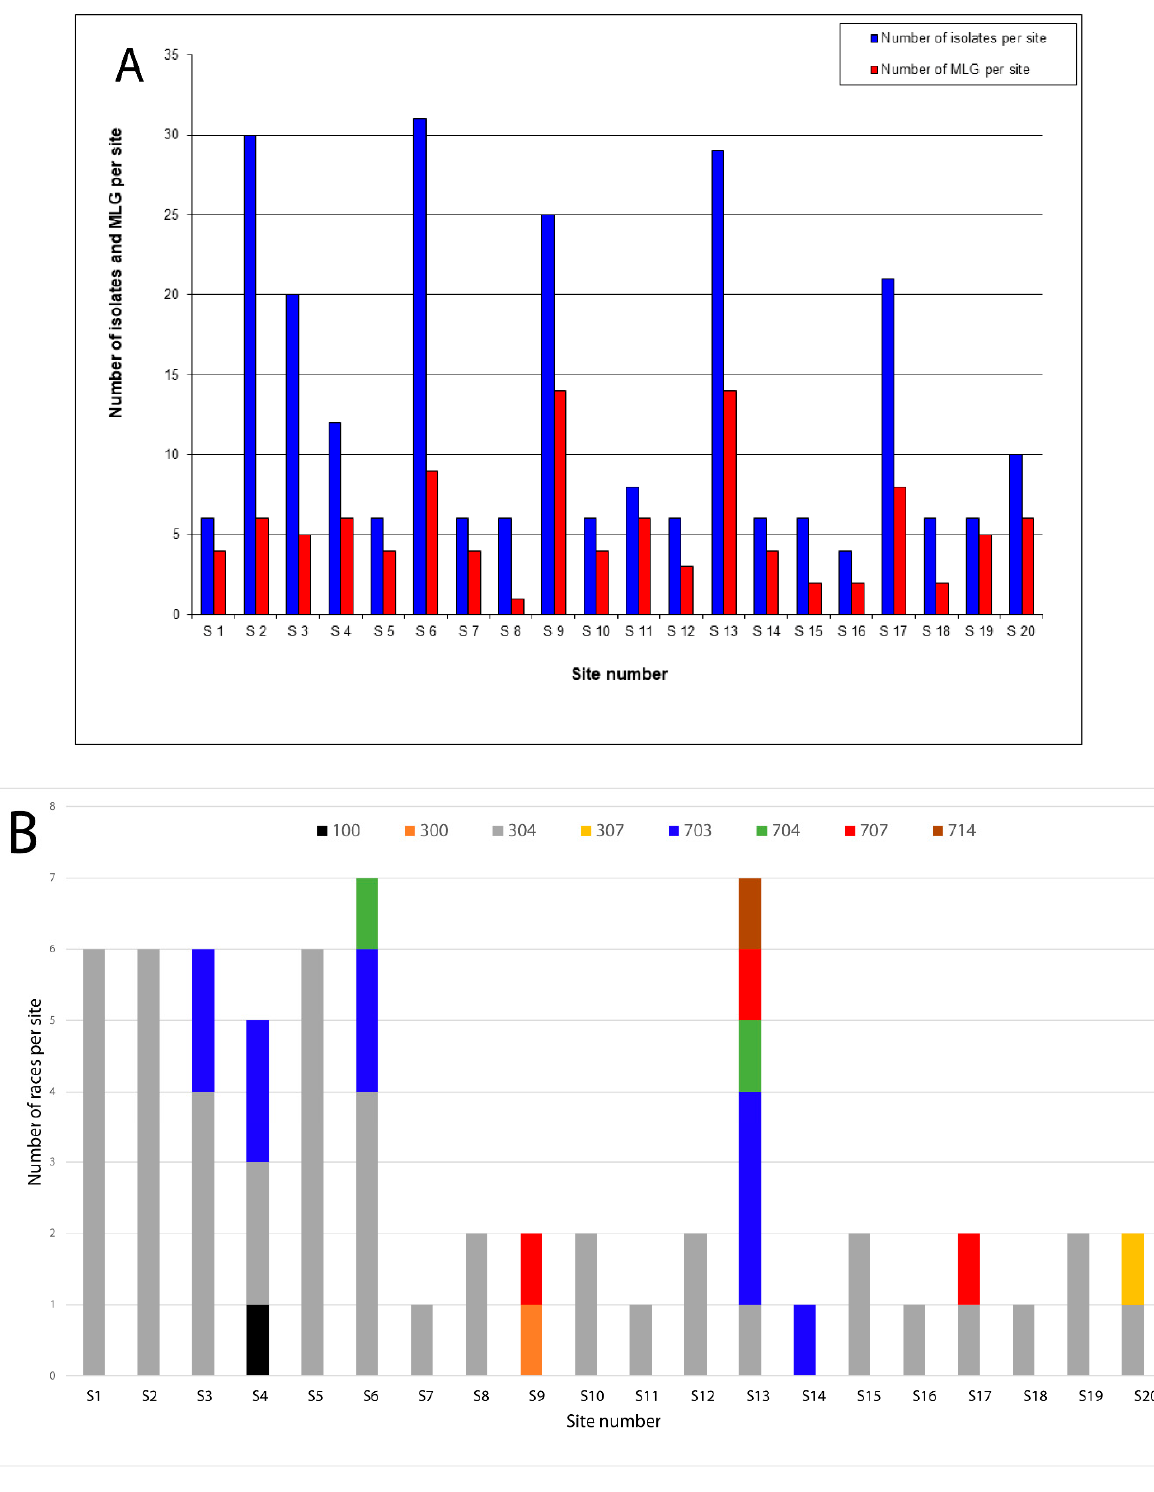
Figure 2. Distribution of P. halstedii within the field at the 20 sites under study. ( A ) Distribution of the total number of sunflower downy mildew isolates (250) and the number of MLG (109) at each site; ( B ) distribution of the eight races of P. halstedii (100, 300, 304, 307, 703, 704, 707, and 714) within the field at the 20 sites, with the co-existence of more than one race at one site ( n = 64). (For interpretation of the references to color in this figure legend, the reader is referred to the web version of this